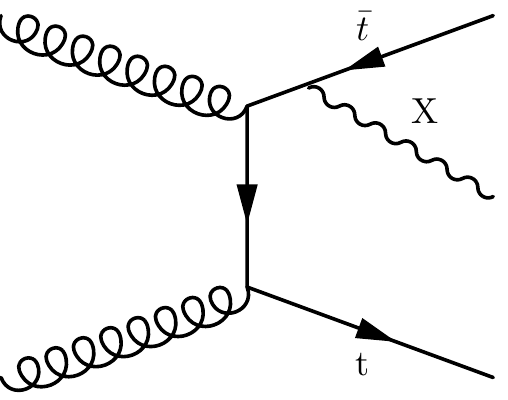
Figure 1. Leading-order Feynman diagram for gluon-gluon top-pair production (gg → t¯t) in associa- tion with a boson